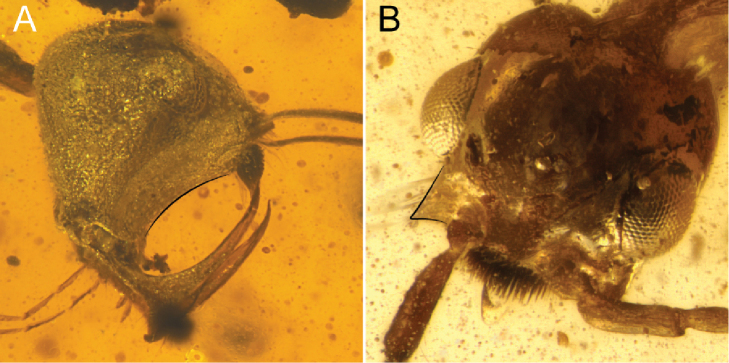
Cranial conformation of clypeal-brush-bearing †HaidomyrmecinaeA †Haidomyrmex
cerberus worker, lateral (FANTWEB00017, AntWeb: Vincent Perrichot) B †Dilobops
bidentata worker holotype, dorsolateral oblique (FANTWEB00039, AntWeb: Gabriel Melo).